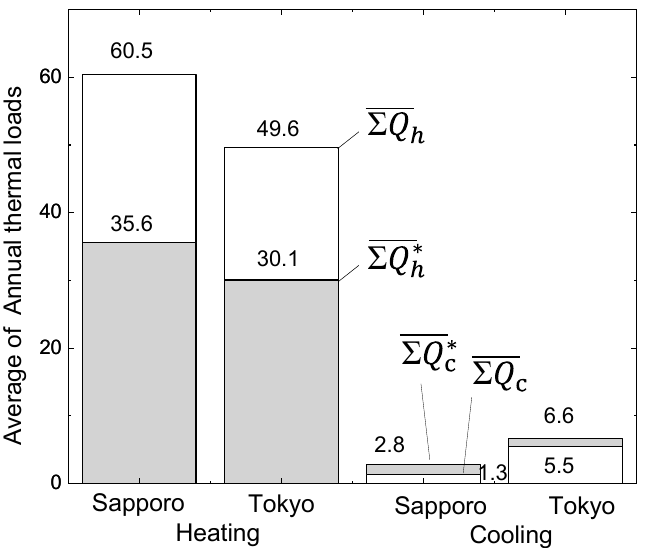
Figure 5. Average annual thermal loads [GJ/y] for heating ( left ) and cooling ( right ) in the present (2001–2020) and future (2076–2095) in Sapporo and Tokyo, Japan.